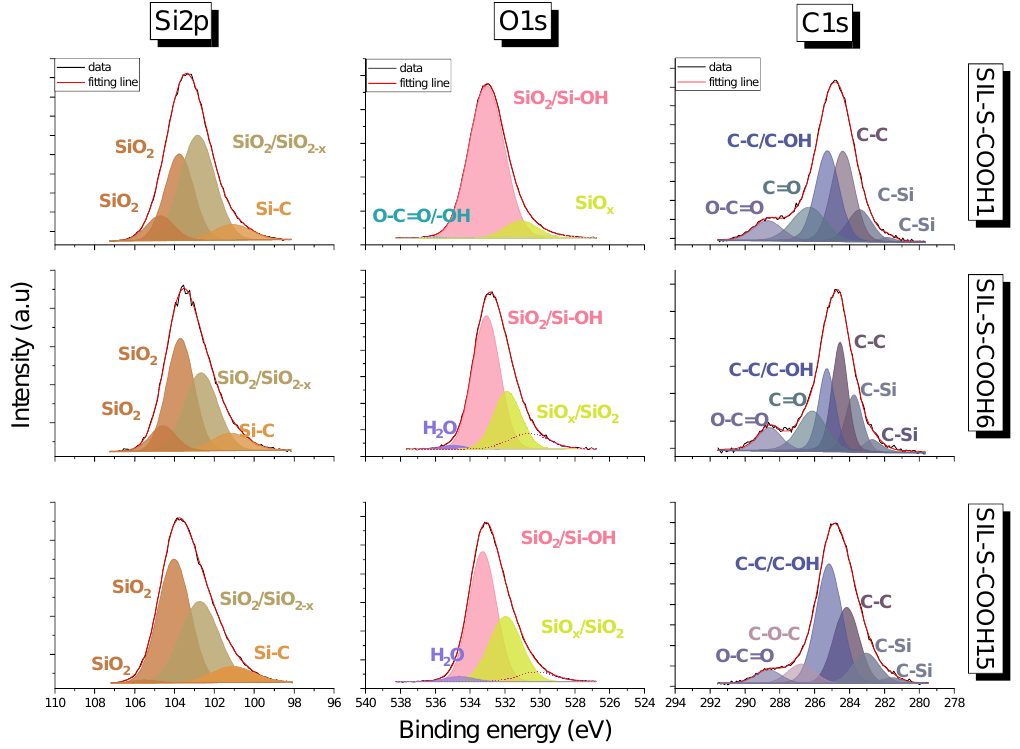
Figure 5. Deconvoluted high-resolution Si2p, O1s, and C1s X-ray photoelectron spectra of the carboxylic acid-containing